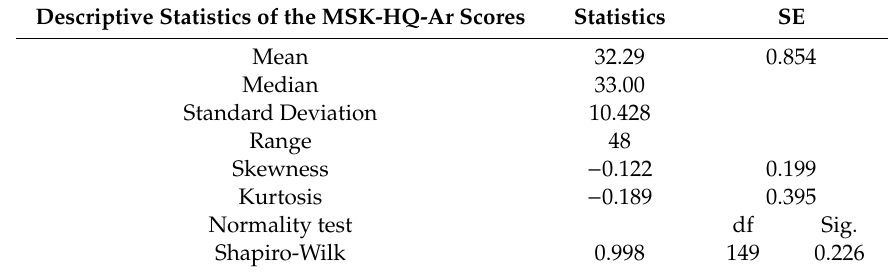
Table 3. Descriptive statistics of the MSK-HQ-Ar scores (musculoskeletal disorders (MSDs) group). Descriptive Statistics of the MSK-HQ-Ar Scores